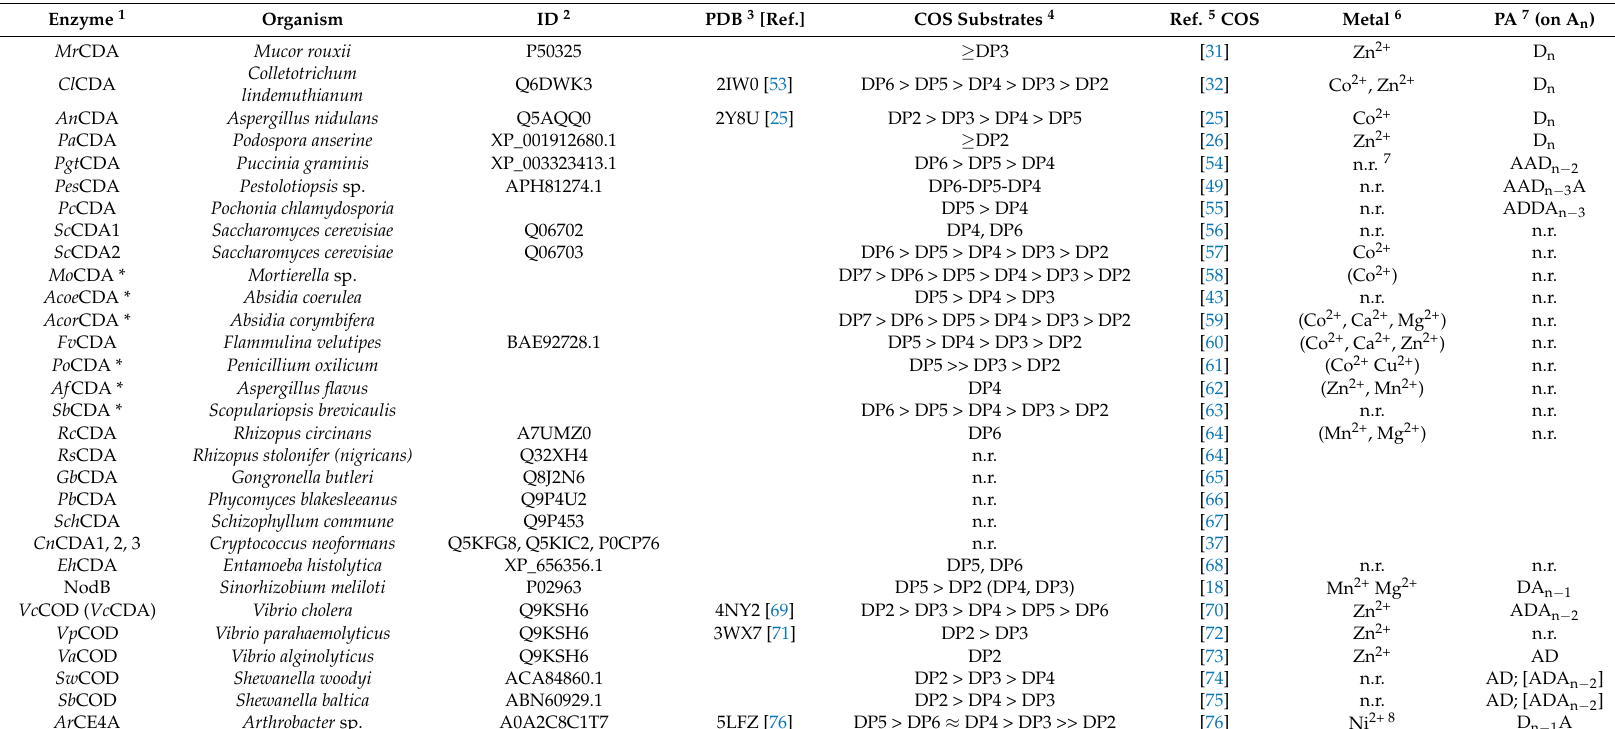
Table 1. CDAs and CODs with characterized activity on